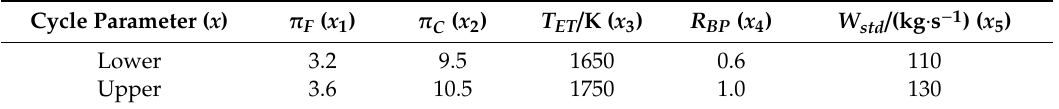
Table 4. Cycle parameter design